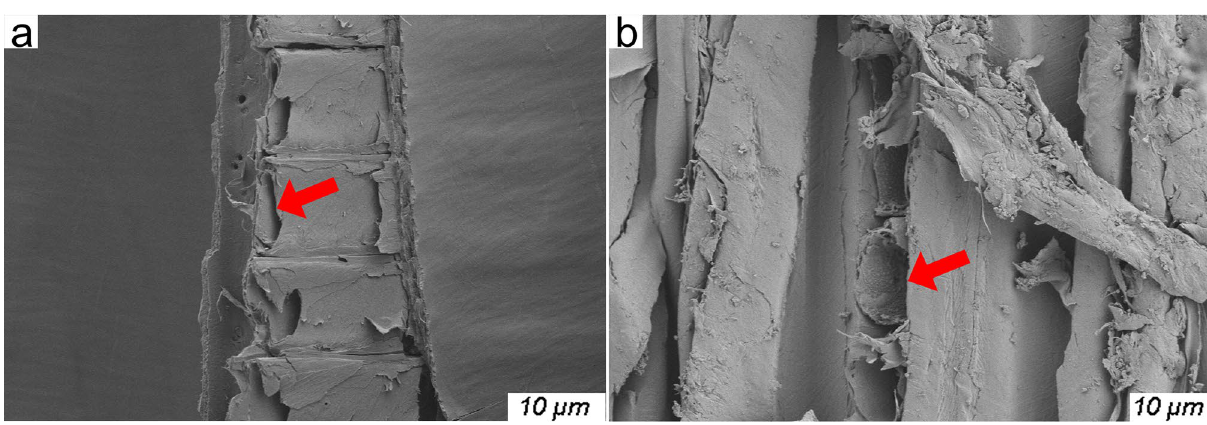
Figure 3. SEM images: original, and pre-treated poplar specimens.